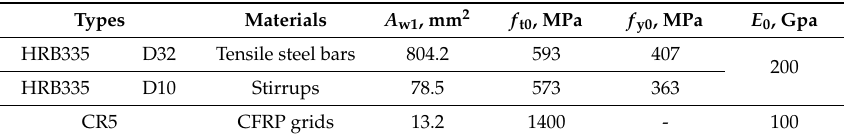
Table 4. Material properties of steel bars and CFRP